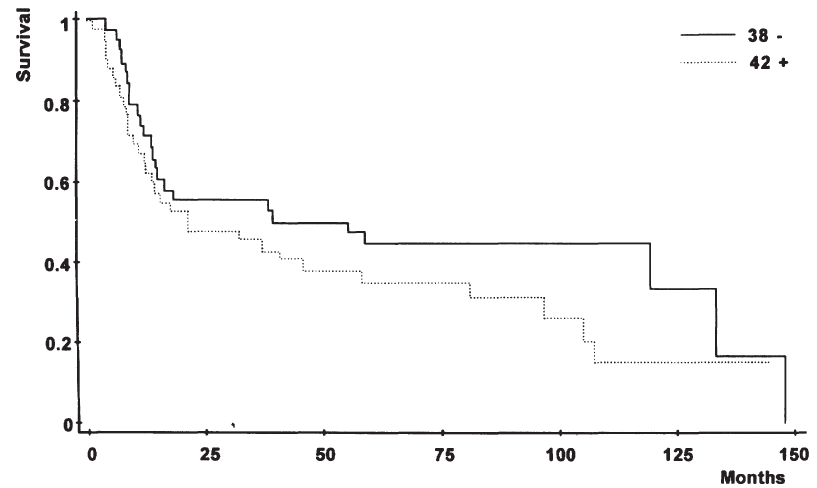
Fig. 3. Crude survival for p53 expression. Patients were divided into two groups: one with p53 positive and the other with p53 negative tumours. No significant difference was found between the groups, though a tendency for worse survival could be seen for patients with p53 positive tumours.